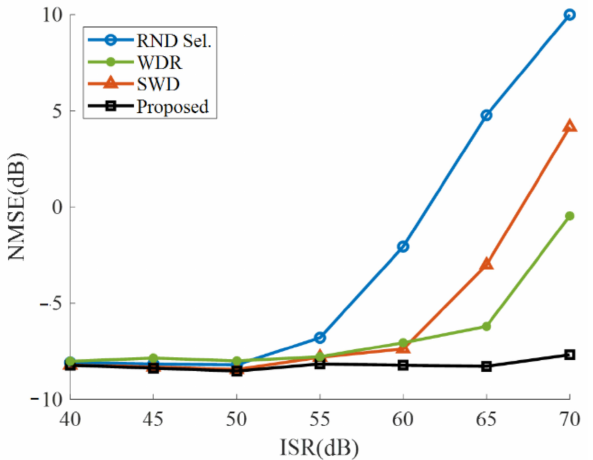
Figure 12. NMSEs of different imaging methods against ISRs. The imaging methods are random selection (RND Sel.), WBI detection and removal (WDR), simple waveform design (SWD), and the proposed